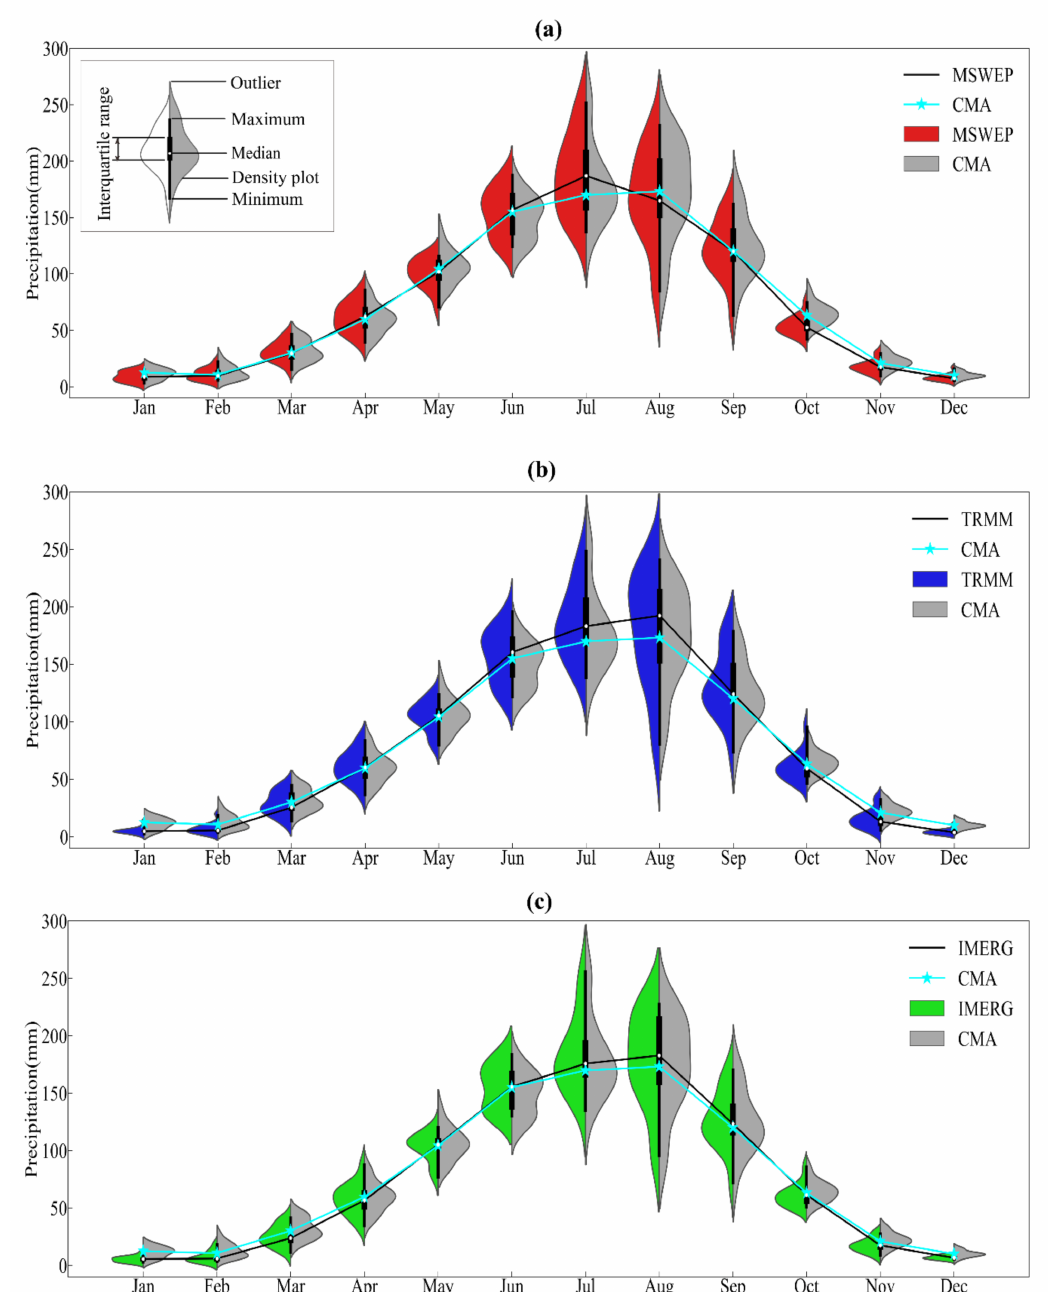
Figure 6. Violin plots illustrating the probability distributions of monthly average precipitation for the three precipitation products, ( a ) MSWEP, ( b ) TRMM, and ( c ) IMERG. The left half of each plot shows a precipitation product, while the right half presents the ground observations (indicated by CMA). Overlapping each violin plot is a box plot summarizing the range from maximum to minimum, the interquartile range (IQR), the median, and outliers. Plots of the CC and KGE comprehensive indices of MSWEP, TRMM, and IMERG in different months are shown in Figure 7. All gridded products had good agreement with ground precipitation. However, their patterns were distributed differently between dry and wet seasons. IMERG showed better skill at detecting the precipitation of the wet season (all CC values exceeded 0.9; all KGE values exceeded 0.8), while MSWEP exhibited the best skill in detecting the precipitation of the dry season. TRMM fell in the middle for CC